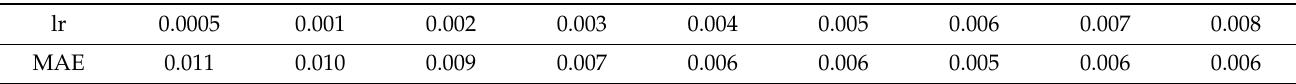
Table 3. Values of the MAE.